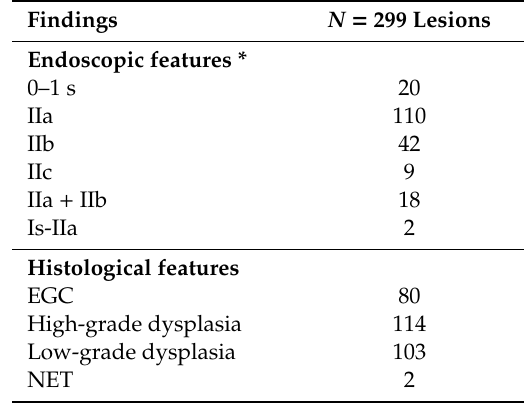
Table 1. Characteristics of lesions at endoscopic and